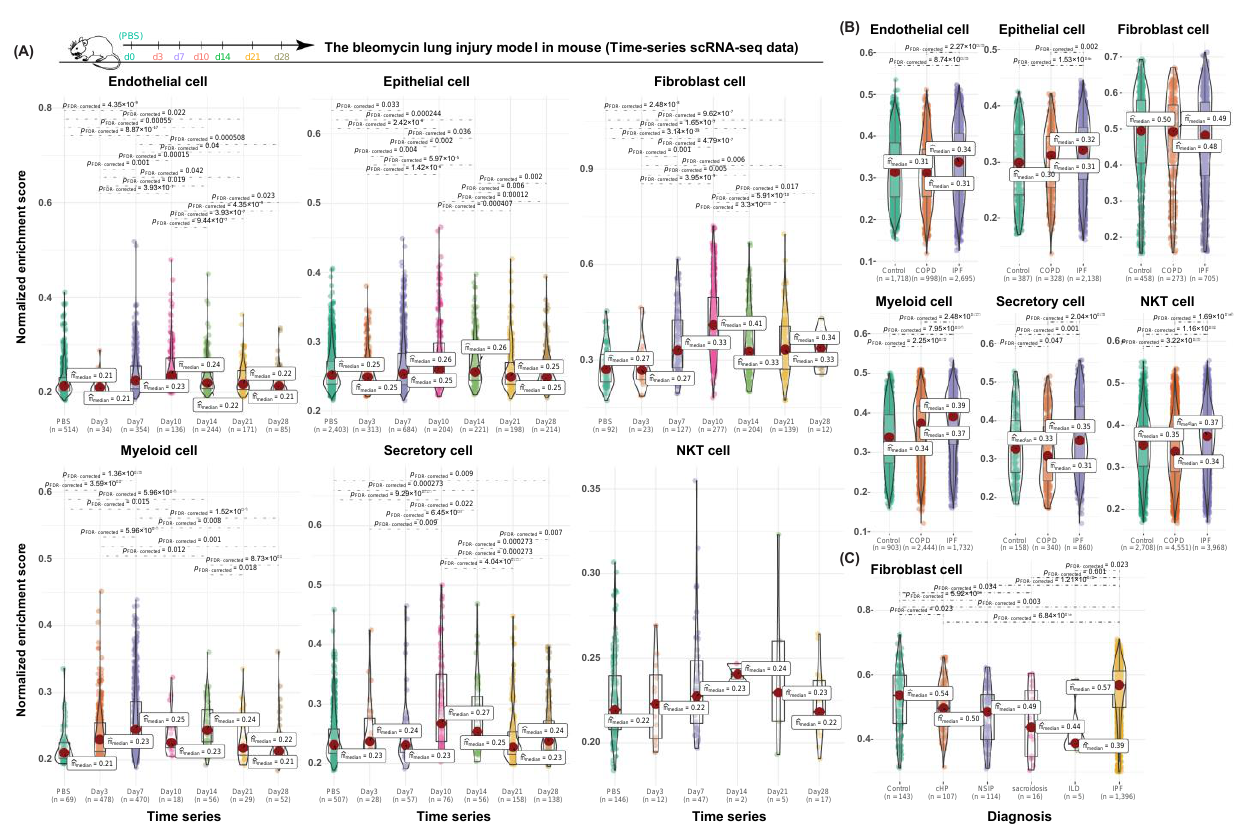
Figure 4. Validation of cell-type-specific gene signatures in single-cell datasets from both humans and mice. ( A ) Box-violin plot of NES ( y -axis) on six different cell types in mouse single-cell time-series dataset. Time points are shown as x -axis. Illustration of longitudinal sample collections is shown on top of the whole panel. ( B ) Box-violin plot of NES ( y -axis) on six different cell types in human lung fibrosis. ( C ) Box-violin plot of NES ( y -axis) on fibroblast cells in human lung fibrosis. For individual box-violin plot, 25th, 50th, and 75th percentiles of the data points are shown with boxplot. Red dot represents the mean. Detailed corrected p values (FDR values) in the pairwise comparisons are labeled on each plot, and only the significant comparisons are shown. Number of total cells contained in each condition is included in parentheses. Abbreviations: cHP, chronic hypersensitivity pneumonitis; COPD, chronic obstructive pulmonary disease; ILD , unclassifiable chronic interstitial lung diseases; IPF, idiopathic pulmonary fibrosis; NSIP, nonspecific interstitial pneumonia.